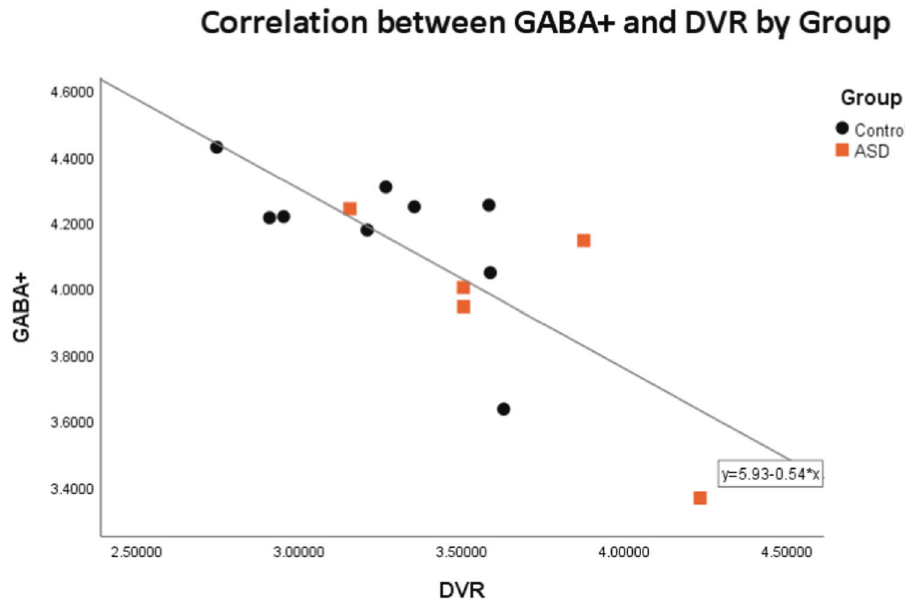
Fig. 4 Correlation between GABA + levels and DVR (Distribution Volume Ratio) of mGluR5 in the left striatum and thalamus. The control group is represented in black and the ASD (Autism Spectrum Disorder) group is represented in orange.